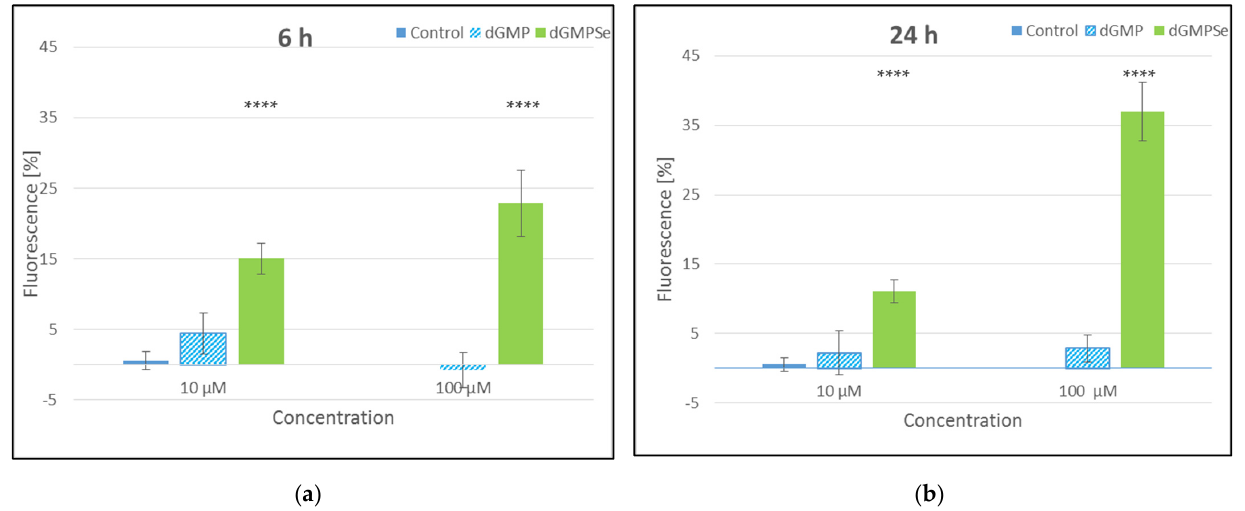
Figure 8. Release of H 2 Se in HeLa cells after addition dGMPSe into the medium with HeLa cells measured after 6 h ( a ) and 24 h ( b ) as of fluorescence intensity (% of Control, detection by SF7, 2.5 µM). As controls, H 2 O or dGMP were used. Levels of SF7 fluorescence were quantified by plate reader and data represent means ±SEM from at least three independent experiment performed in triplicate (**** p < 0.00001).